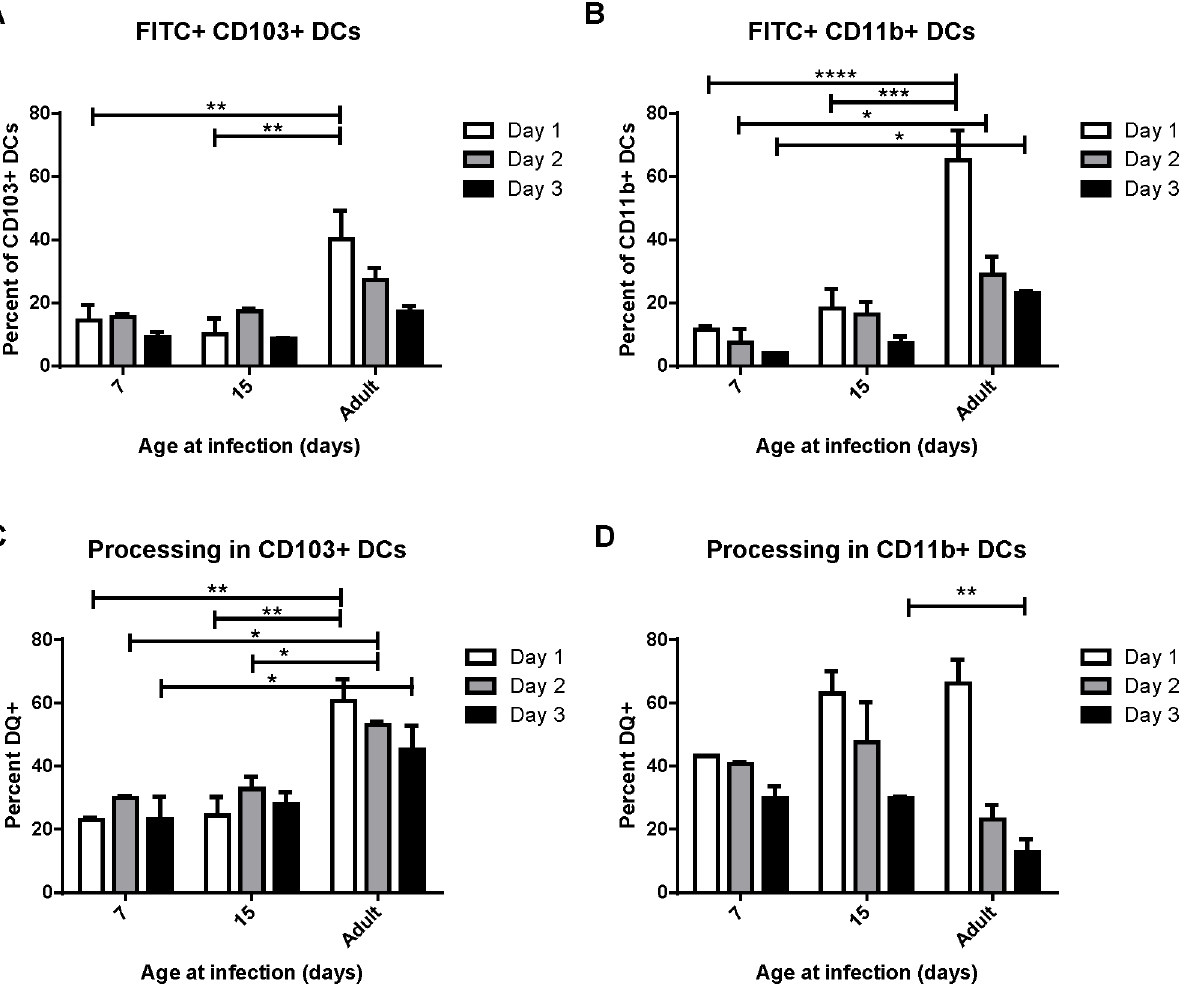
Figure 3. Uptake and processing of soluble antigen is age-dependent. Soluble ovalbumin-FITC protein (A and B) or ovalbumin-DQ (C and D) were co-administered at the time of RSV infection and the percent of the CD103 + and CD11b + DC populations positive for FITC expression (A or B) or shown to be processing antigen by unquenching of ova-DQ were measured in the MLN at days 1, 2, and 3 post-infection. Data are combined from two independent experiments using pooled lymph node samples (3–7 mice/pool depending on age and availability) and error bars indicate the SEM. * p # 0.05, **p # 0.01, ***p # 0.001, **** p # 0.0001 by two-way ANOVA and Tukey’s multiple comparisons test.